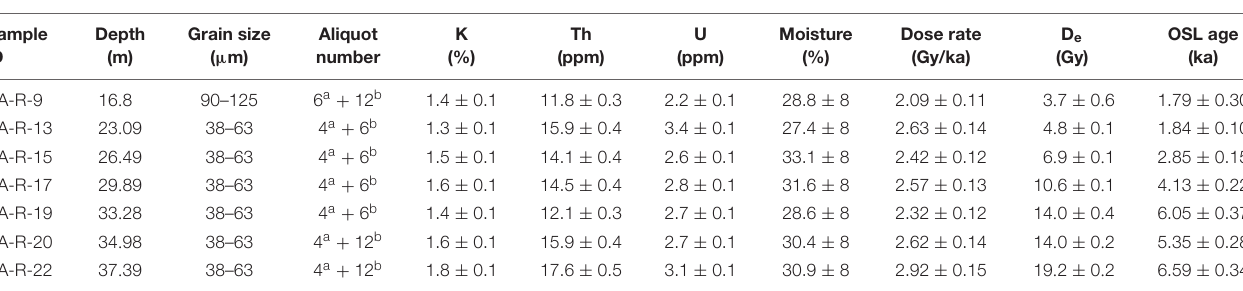
FIGURE 3 | Luminescence properties of sample DA-R-09 (A) and DA-R-20 (B) . The black lines and red lines represent OSL decay curves of the natural signal and regeneration signal, respectively. The growth curves are shown in the set charts. Black cycles, regenerative doses; Red cycles, recycled doses; hollow square, natural doses. TABLE 1 | OSL dating results from core